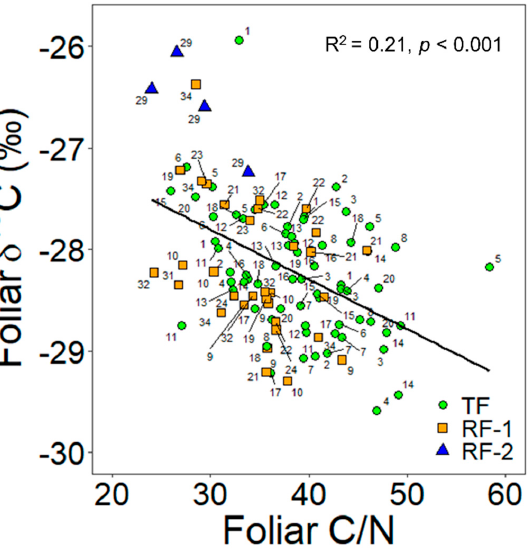
Figure 6. Relationships between the foliar δ 13 C and C/N for each tree sample from the TF ( n = 68), the RF-1 ( n = 33), and the RF-2 ( n = 4). Each sample was labeled with a plot number. Black solid line shows the linear regression line for all samples in the transect.